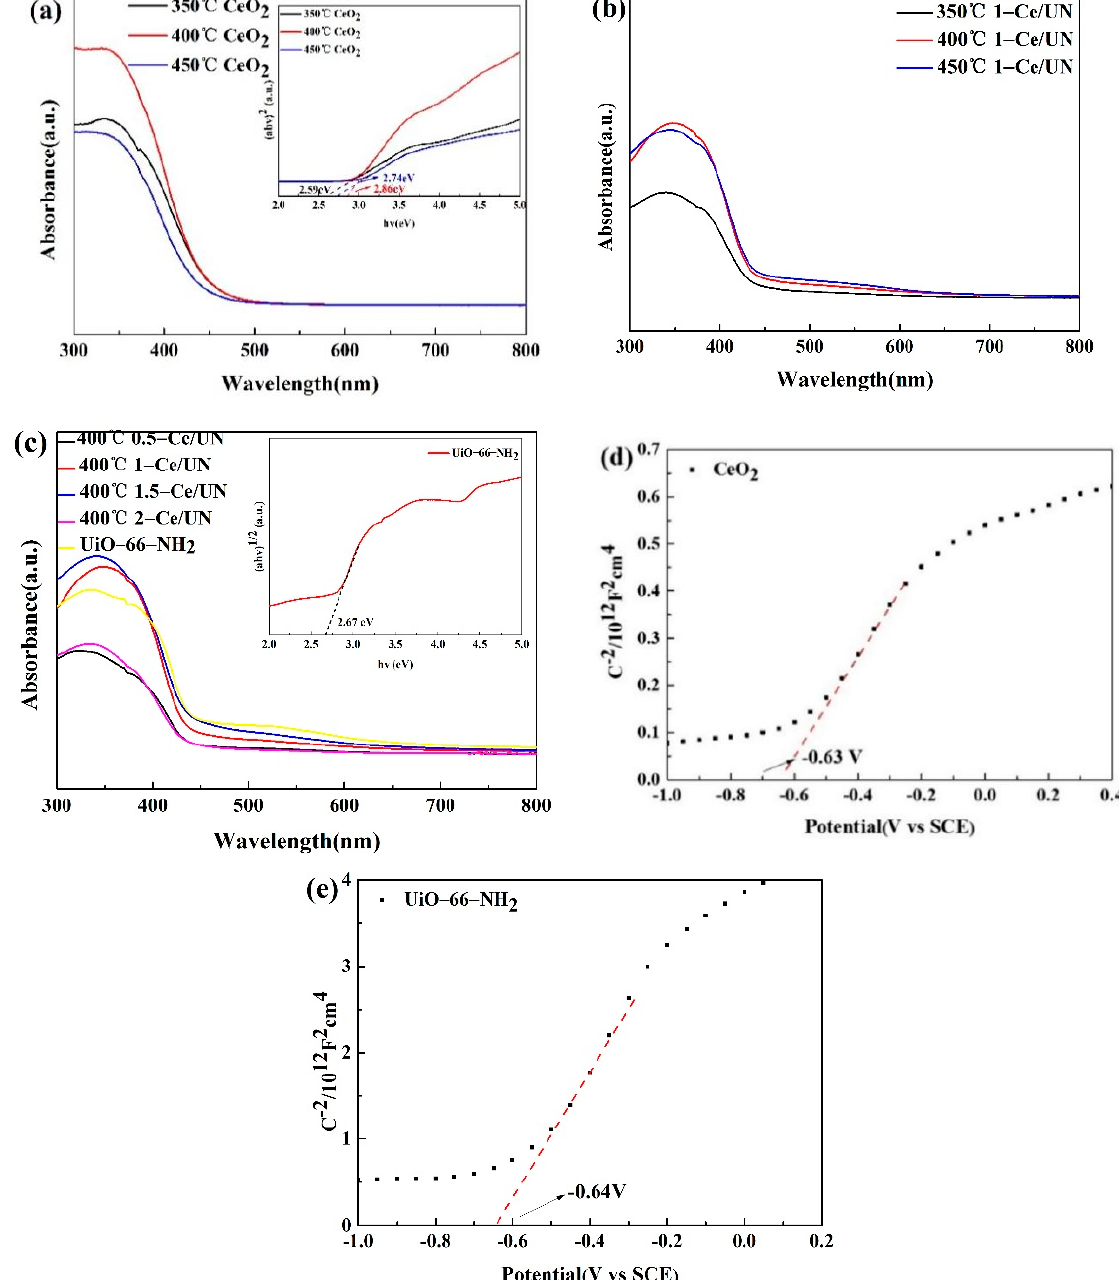
Figure 13. UV-Vis reflectance spectrum of ( a ) CeO 2 prepared at different temperatures, ( b ) (350 °C, 400 °C, 450 °C)1-Ce/UN, ( c ) Ce/UN composites with different composite ratios, and the Mott–Schottky curve of ( d ) CeO 2 and ( e ) UiO-66-NH 2 .